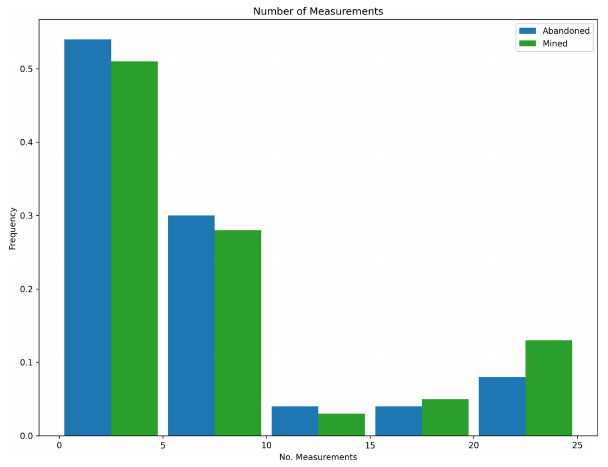
Figure 23. Measurement histogram, POMCPOW without action constraints, single body with variable location. This figure shows a histogram of the number of measurements taken by the POM- CPOW solver over all Monte Carlo trials. The trials were limited to a maximum of 25 measurements.